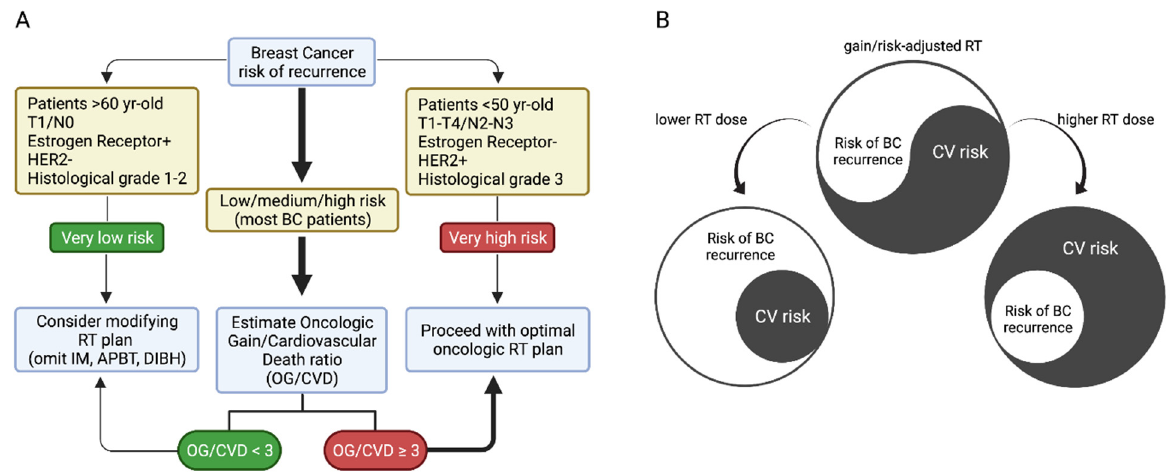
Figure 2. ( A ) Proposal for the classification of patients with indications of radiotherapy for breast cancer. ( B ) simplified scheme of cardiac dose impact on risk balance.